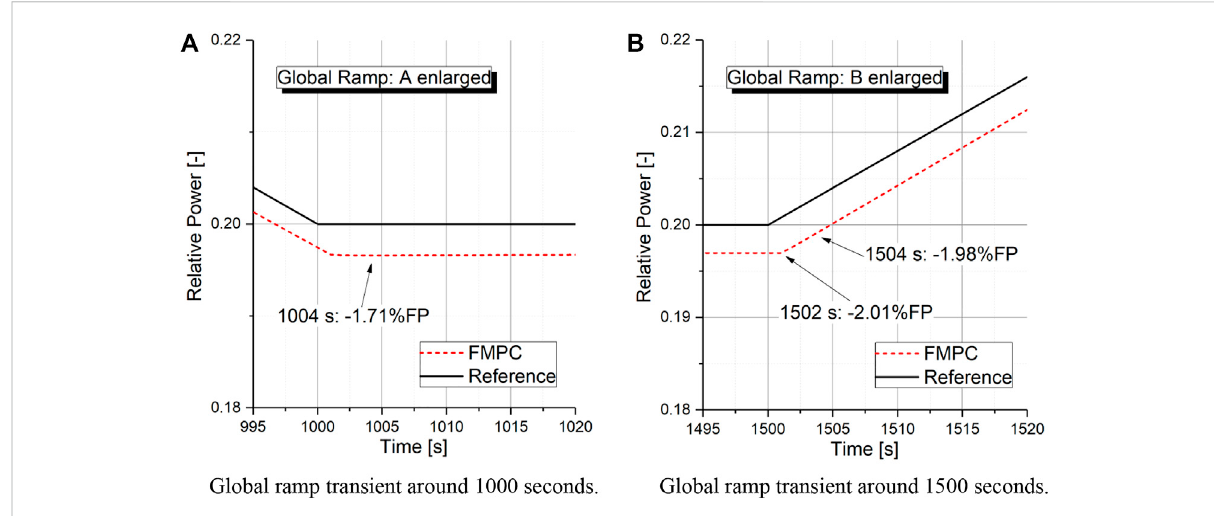
Enlarged view of the area A and B for the global ramp transient. (A) Global ramp transient around 1,000 s. (B) Global ramp transient around 1,500 s.